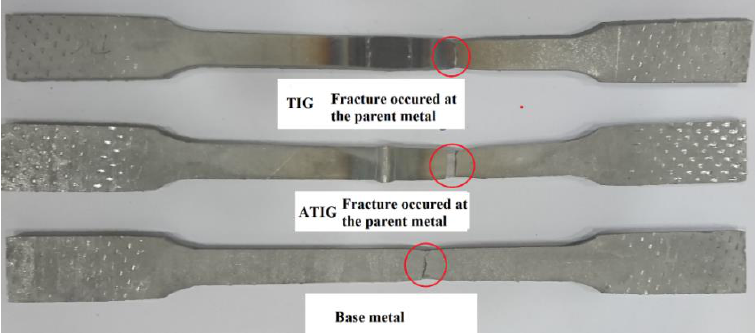
Figure 11. Tensile test results. Table 7. Mesurments of tensile strenght and standards deviation of TIG and ATIG (optimal flux).